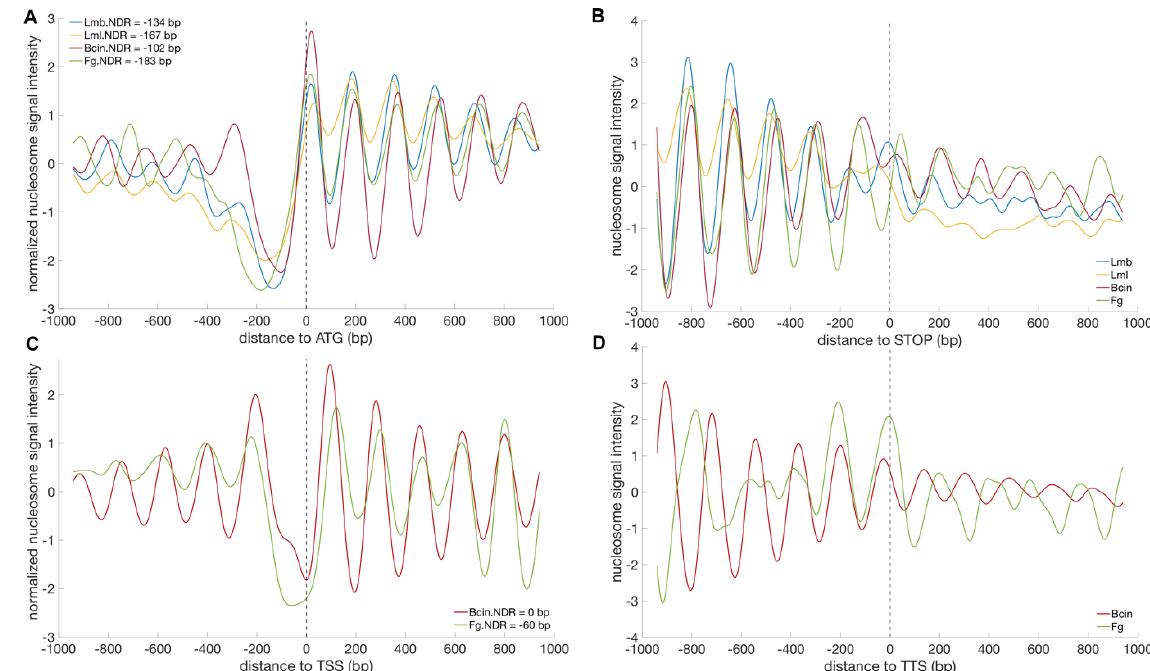
Figure 7: Nucleosome organization of near-universal single copy orthologous gene units in Fungi (BUSCO3). A-D. Scaled (z-scored) averages (three biological replicates for each fungus/condition) of nucleosome signals as a function of position (in base pairs) relative to the start codon ATG (A), the stop codon (B), TSS (C), and TTS (D). Fg = Fusarium graminearum ; Lmb = Leptosphaeria maculans ‘brassicae’; Lml = Leptosphaeria maculans ‘lepidii; Bcin = Botrytis cinerea ; NDR = nucleosome-depleted